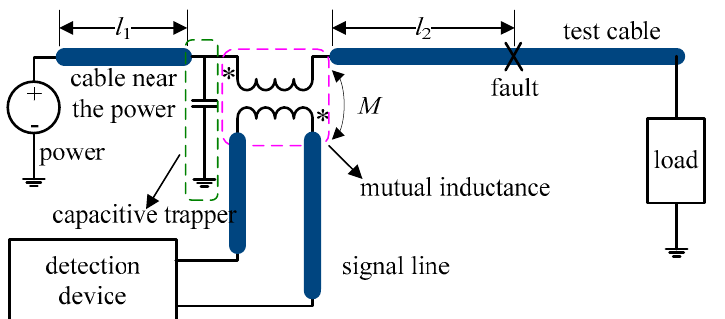
Figure 4. Diagram of non-intrusive inductive coupling cable fault diagnosis, l1 is the distance between the detection device and the power source, l2 is the distance from the detection device to cable fault, M is the mutual inductance of the coupler.